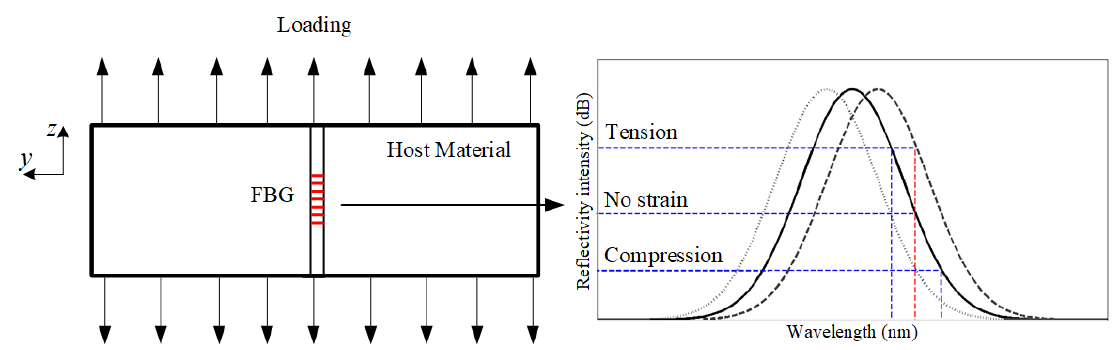
Figure 13. The force analysis of the FBG sensor when axial places on the aluminium plate under axial loading and the FBG reflection spectrum shift under no strain field, tension stress field and compression field.